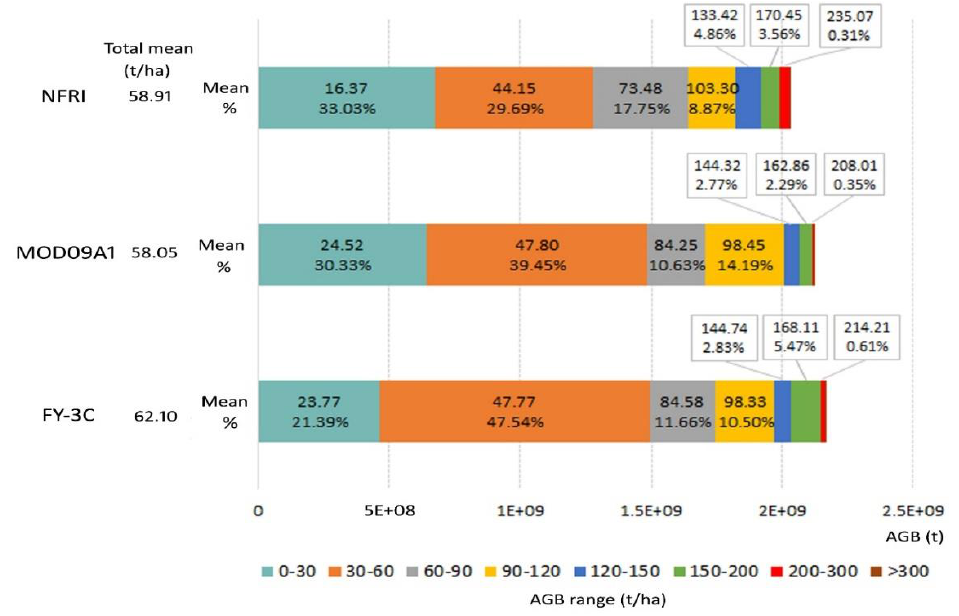
Figure 6. Distribution of forest AGB in the Chinese National Forest Resource Inventory (NFRI) dataset and estimated forest AGB based on MOD09A1 and FY-3C VIRR imageries by RF models.